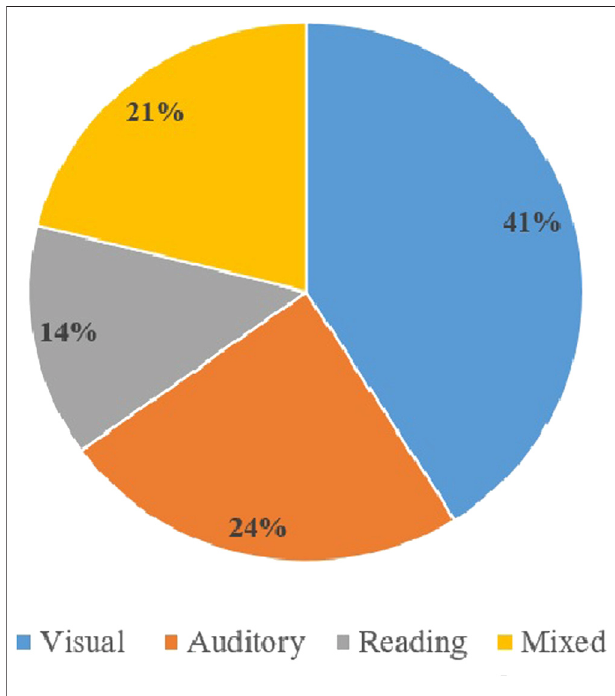
FIGURE 5 | Distribution of learning